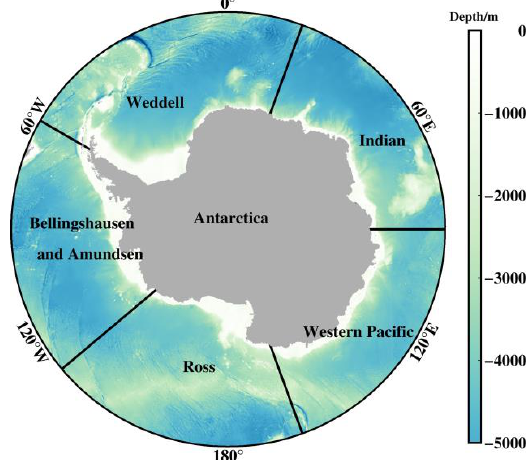
Figure 1. Map of the Southern Ocean and five subregions.